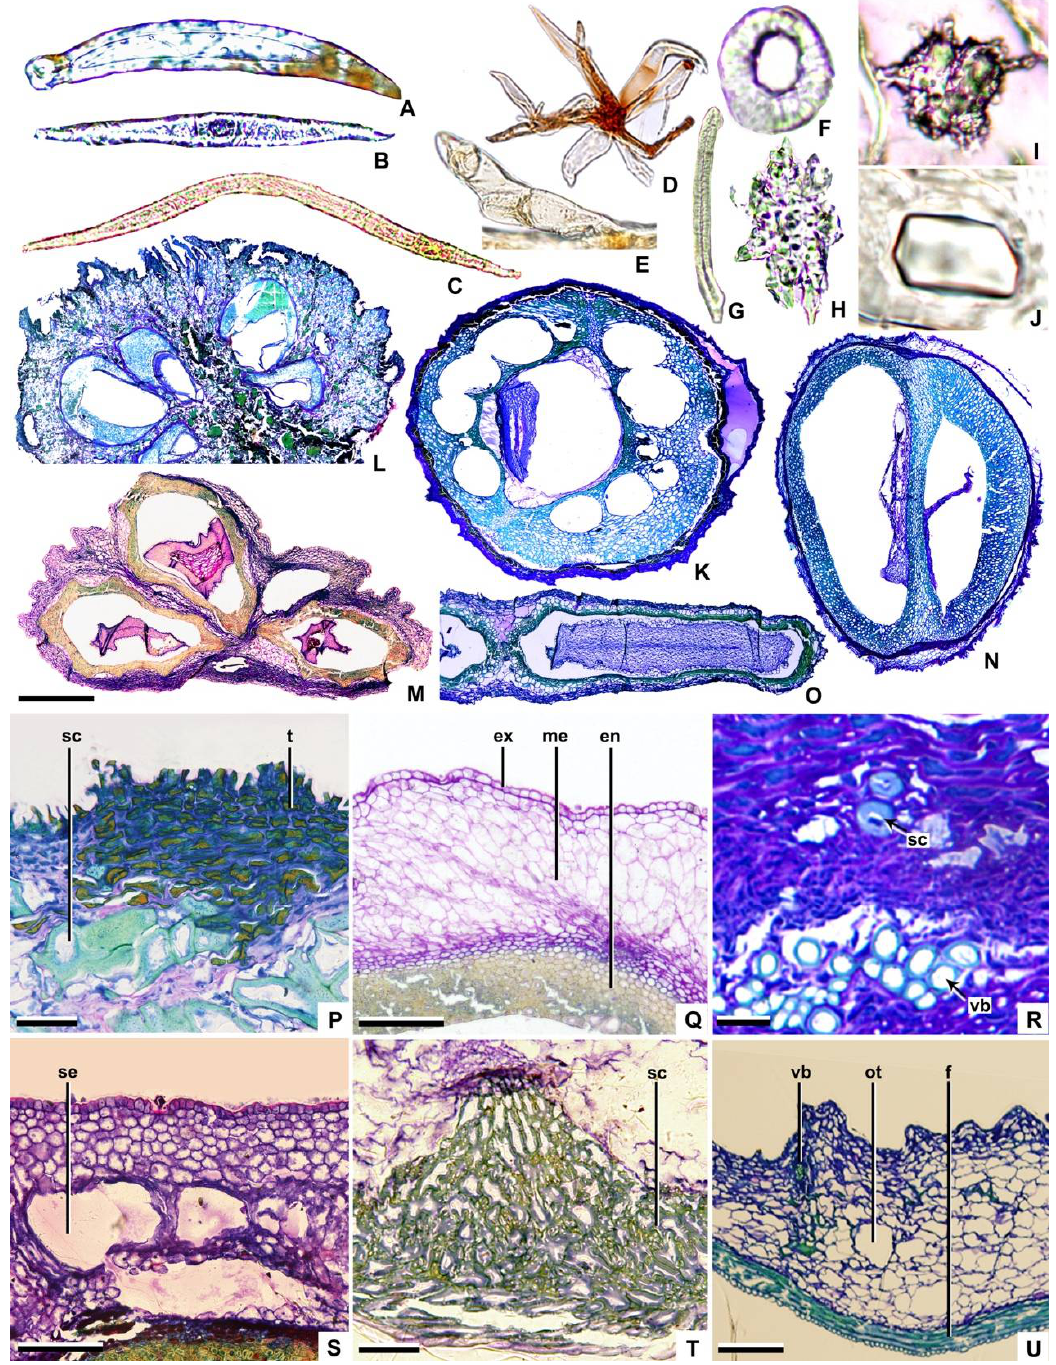
Figure 2. Trichome ( A – E ), sclereid ( F – H ), crystal ( I , J ), transverse sections of fruit ( K – U ). ( A ) Aucuba japonica ; ( B ) Cornus controversa ; ( C ) C. chinensis ; ( D ) Heteropanax brevipedicellatus ; ( E ) Kalopanax septemlobus ; ( F ) Cornus controversa ; ( G ) Helwingia japonica ; ( H ) Torricellia angulate ; ( I ) Cornus officinalis ; ( J ) C. hemsleyi ; ( K ) C. chinensis ; ( L ) C. capitata ; ( M ) Helwingia chinensis ; ( N ) Cornus macrophylla ; ( O ) Heteropanax brevipedicellatus ; ( P ) Cornus capitata ; ( Q ) C. alba ; ( R ) C. macrophylla ; ( S ) C. ulotricha ; ( T ) Torricellia angulate ; ( U ) Kalopanax septemlobus ; sc = sclereid, t = tannin, ex = exocarp, me = mesocarp, en = endocarp, vb = vascular bundle, se = secretary cavity, ot = oil tube, f = fiber; scale bars = 50 μm in ( A , P , T ); 80 μm in ( B ); 100 μm in ( C , Q , S ); 300 μm in ( D , E ); 35 μm in ( F , H , I ); 70 μm in ( G ); 10 μm in ( J ); 600 μm in ( K ); 400 μm in ( L , O ); 800 μm in ( M ); 500 μm in ( N ); 30 μm in ( R ); and 200 μm in ( U ).